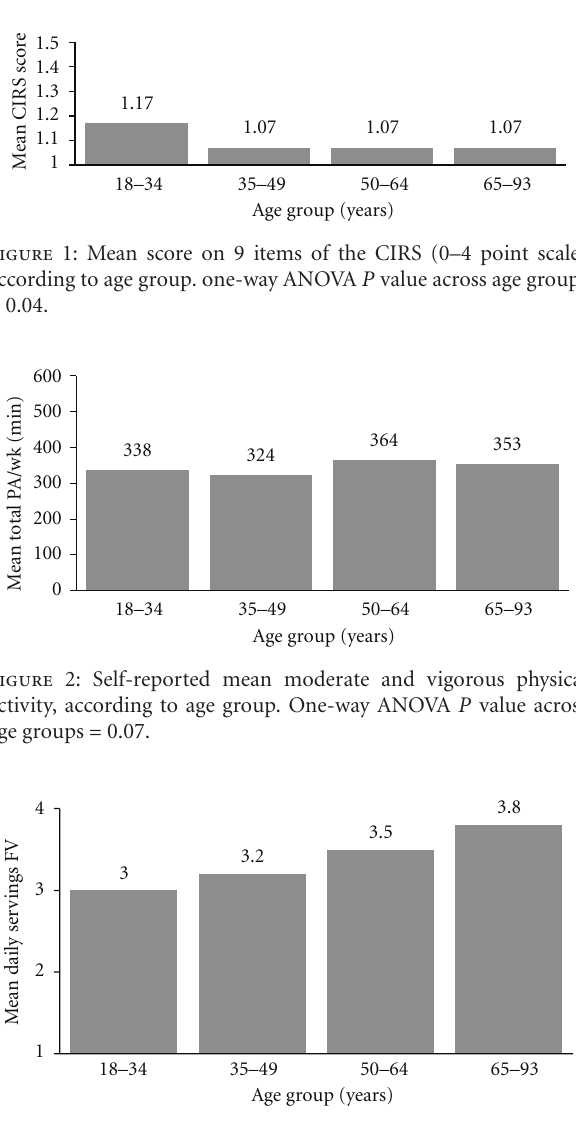
Figure 3: Self-reported mean fruit and vegetable intake, according to age group. one-way ANOVA P -value across age groups <